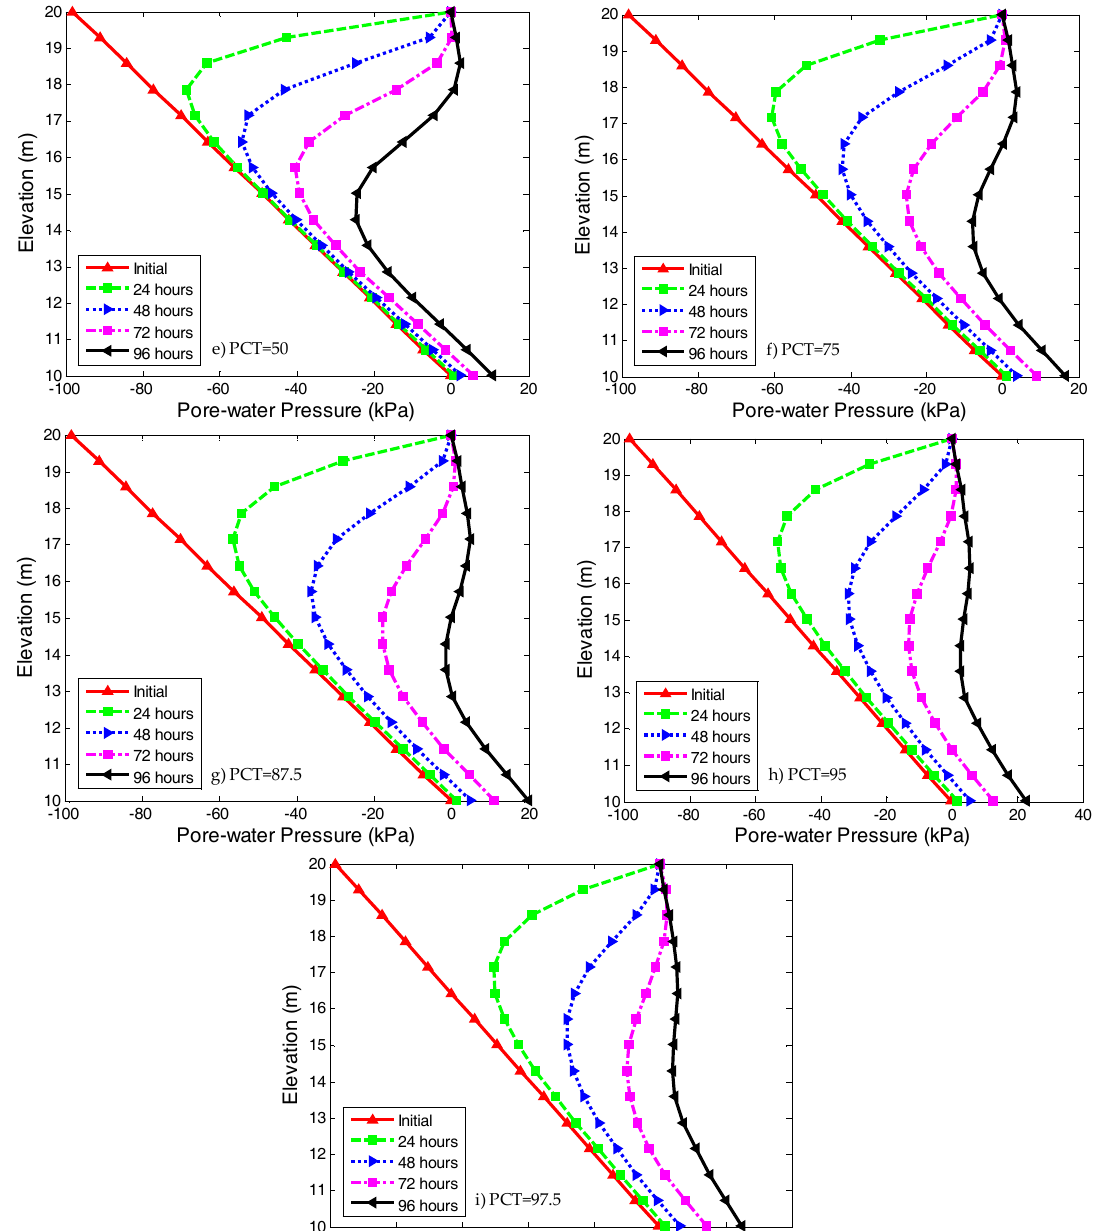
Figure 8. Pore-water pressure profiles at section O–O in slopes with different percentiles of SWCC. ( a ) PCT = 2.5; ( b ) PCT = 5; ( c ) PCT = 12.5; ( d ) PCT = 25; ( e ) PCT = 50; ( f ) PCT = 75; ( g ) PCT =